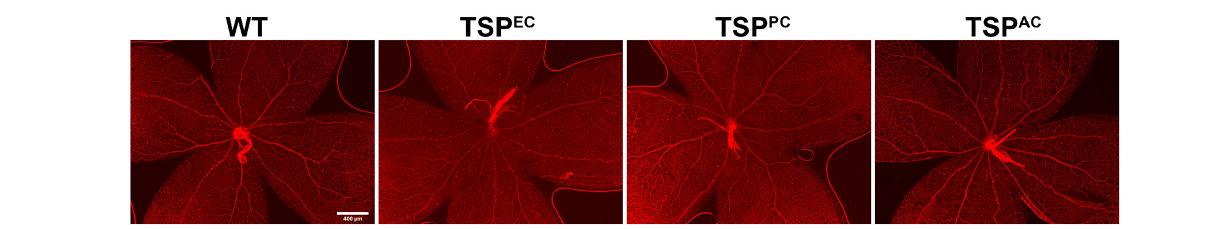
FIGURE 3 | Supercritical retinal vascular layer. Retinal wholemount preparation from P7 mice were stained with anti-collagen IV. Eyes from at least five mice were stained. Please note no gross abnormalities were noted. Scale bar = 400 µ m.